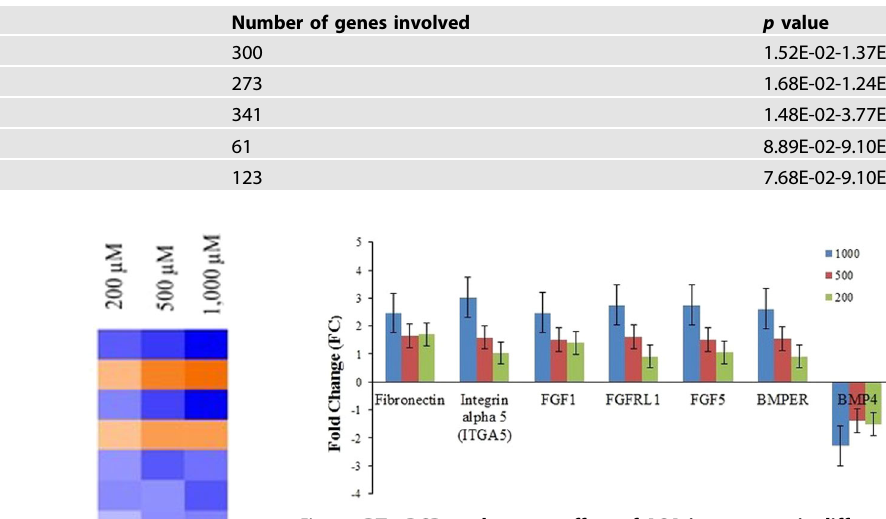
Fig. 4 RT-qPCR analyses on effect of ASA in osteogenic differentia- tion of PDLSCs. Real-time RT-PCR analyses of FN1, Ig α 5, FGF1, FGF5, FGFRL1, BMP4, and BMPER on effect of ASA at 1000 μ M in osteogenic differentiation of PDLSCs ( n =